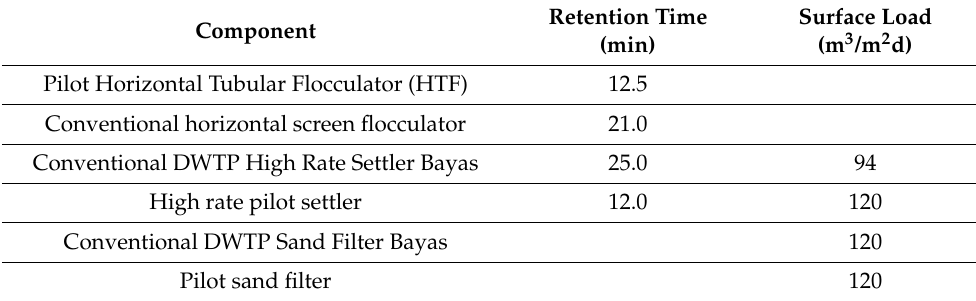
Table 16. Specifications of the pilot system and the conventional